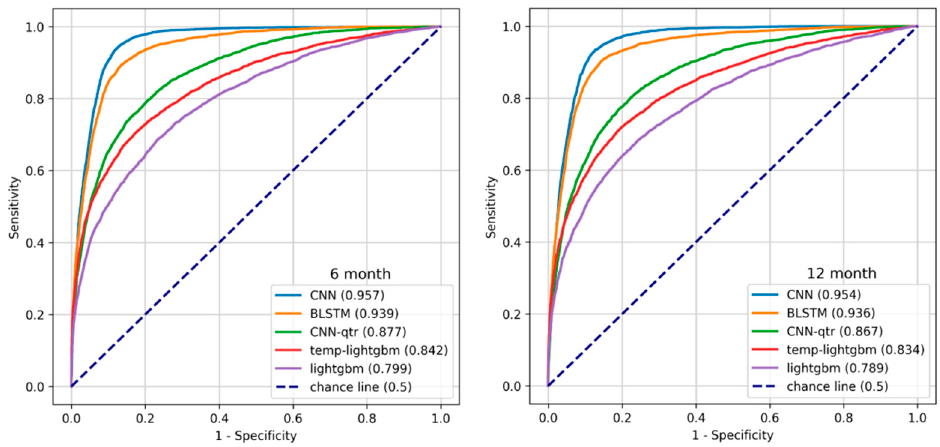
Figure 6. ROC curves of representative models.